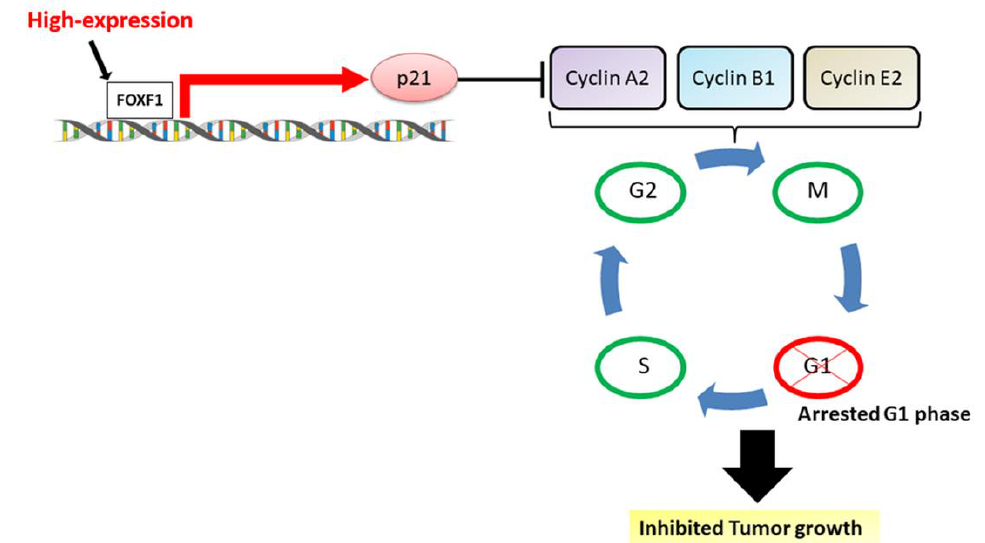
Figure 8. Schematic of possible mechanistic insight into FOXF1-inhibited non-small-cell lung cancer growth via inducing tumor suppressor and G1-phase cell-cycle